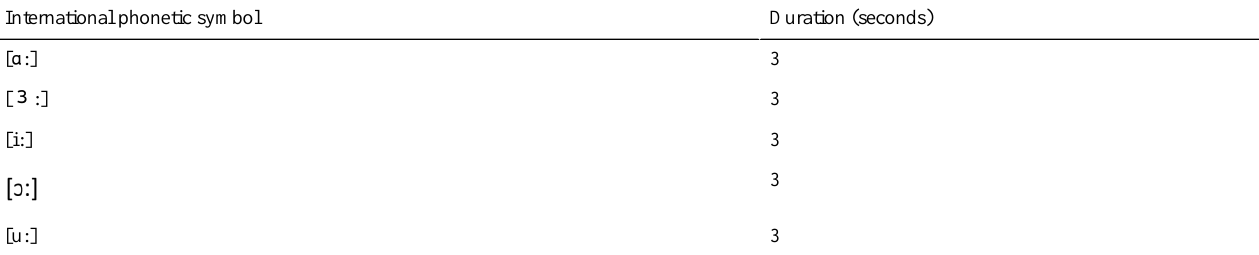
Table 1. Collected